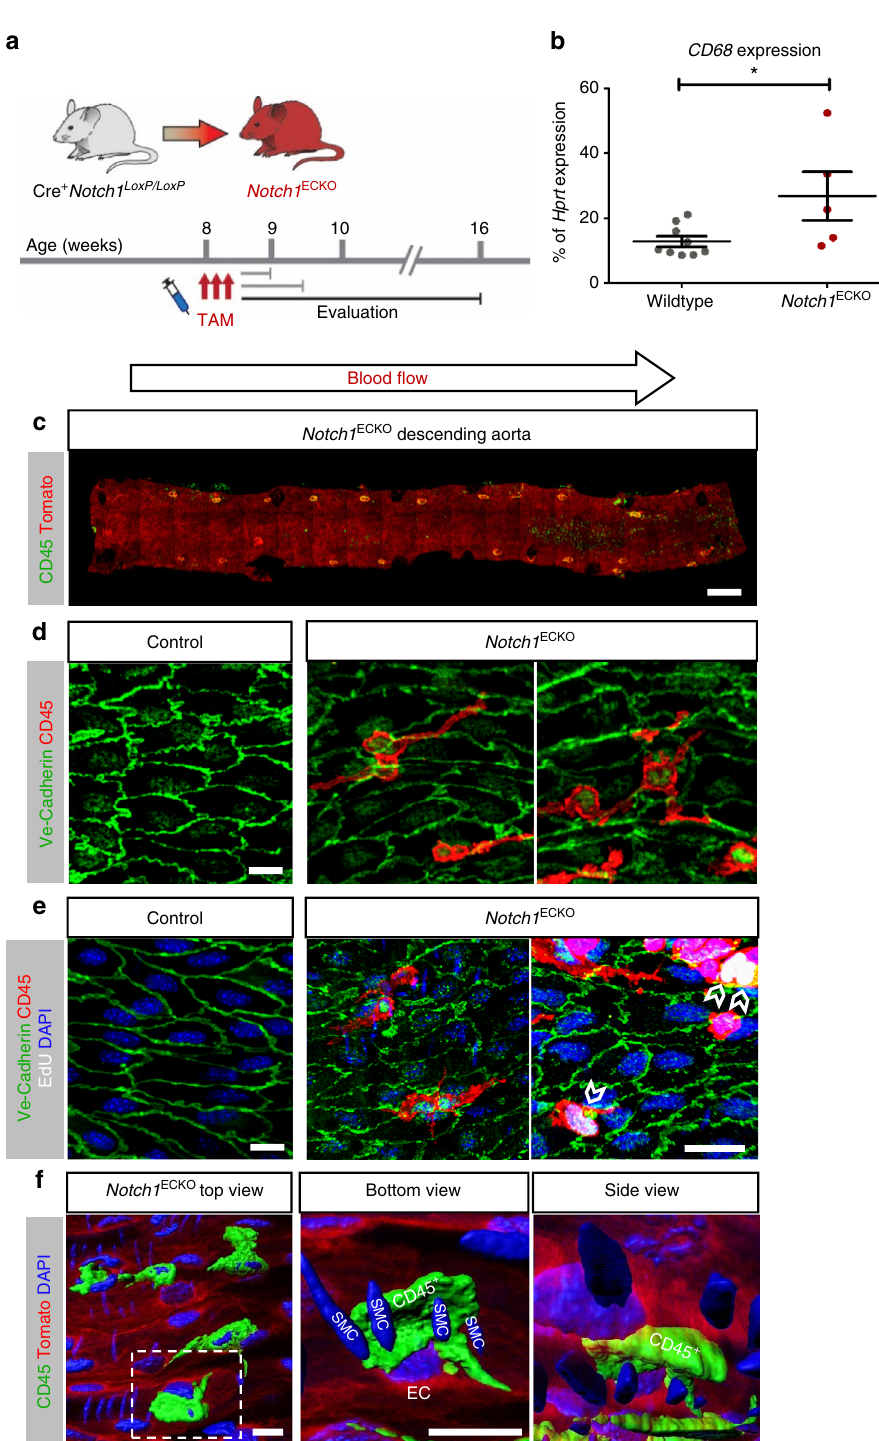
Fig. 8 In vivo deletion of endothelial Notch1 results in in fl ammatory cell recruitment. a Timeline for inducible deletion of endothelial Notch1 to indicate animal ages and evaluation time points. b Quanti fi cation of CD68 expression from the intima of descending aortae of adult WT mice ( n = 9) and Notch1 ECKO mice ( n = 5) 2 weeks post tamoxifen by qPCR analysis. Graph bars represent average ± SEM, T -test * P < 0.01. c Confocal tile scan of the descending aorta of Notch1 ECKO animal at 8 weeks post tamoxifen reveals the presence of CD45 + tdTomato − cells embedded within the tdTomato + endothelium. Scale bar = 500 µ m. d Ve-Cadherin and CD45 staining of control (Cre − Notch1 loxP/loxP ) and Notch1 ECKO descending aortae at 8 weeks post tamoxifen displays CD45 + in fl ammatory cells at higher magni fi cation in the Notch1 ECKO aorta; scale bar = 10 µ m. e En face imaging of the endothelium by Ve-Cadherin staining in the descending aorta of control (Cre − Notch1 loxP/loxP ) and Notch1 ECKO mice, both tamoxifen-injected and sacri fi ced after 8 weeks, shows proliferating (EdU + ) CD45 + in fl ammatory cells (marked by open arrow heads) embedded within the endothelial layer of Notch1 ECKO mice; scale bars = 10 µ m. f Three-dimensional surface render to visualize the spatial location of marked CD45 + cell relative to the endothelium (marked EC) and smooth muscle cells (marked SMC). Both bottom and side view reveal that the CD45 + cell is locating above the smooth muscle cell layer. Scale bars = 10 µ